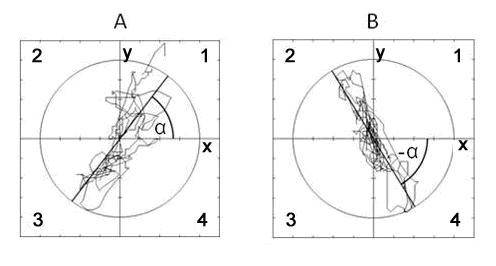
Representative stabilograms indicating AP (y) and ML (x) excursions of COP. A: COP excursion of a patient who had left lower leg amputation. The correlation coefficient is Rxy = 0.75 (p <0.001). The regression line tends from the (left) prosthesis heel towards the right (intact) sole and the angle of regression line is  a = 53°. B: COP excursion of a right leg amputee. The correlation coefficient is: Rxy = 0.72 (p <0.001) and the angle of regression line is    a = -48°. The regression line trends from the (right) prostheses heel towards the left intact sole. The quadrants of the coordinate system are marked with numbers: 1, 2, 3 and 4.